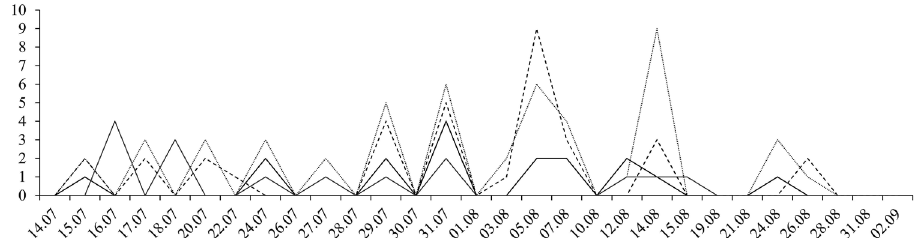
Figure 8. Time interval of capture events during 2015. Capture events of O. eremita during the MIPP project monitoring in 2015 in four Italian study sites (grey line = Foresta della Lama; black line = Feudo Intramonti e Colle di Licco; black dashed line = Val Fondillo; black dotted line = Difesa di Pescasseroli). Table 5. Dataset of mark recapture during 2015. Summary of mark-recapture data obtained during the study of O. eremita in Italy with different capture methods during 2015 in the two macroareas PA and FC (BCWT = Black Cross Windows Traps; PT = Pitfall Traps; PA= Parco Nazionale d’Abruzzo Lazio e Molise; FC = Foreste Casentinesi; VF = Val Fondillo; DP = Difesa di Pescasseroli; FI = Feudo Intramonti e Colle di Licco; CA = Camaldoli; FL = Foresta della Lama). BCWT PT Site Marked beetles Marked beetles ( ♀ / ♂ ) ( ♀ / ♂ )